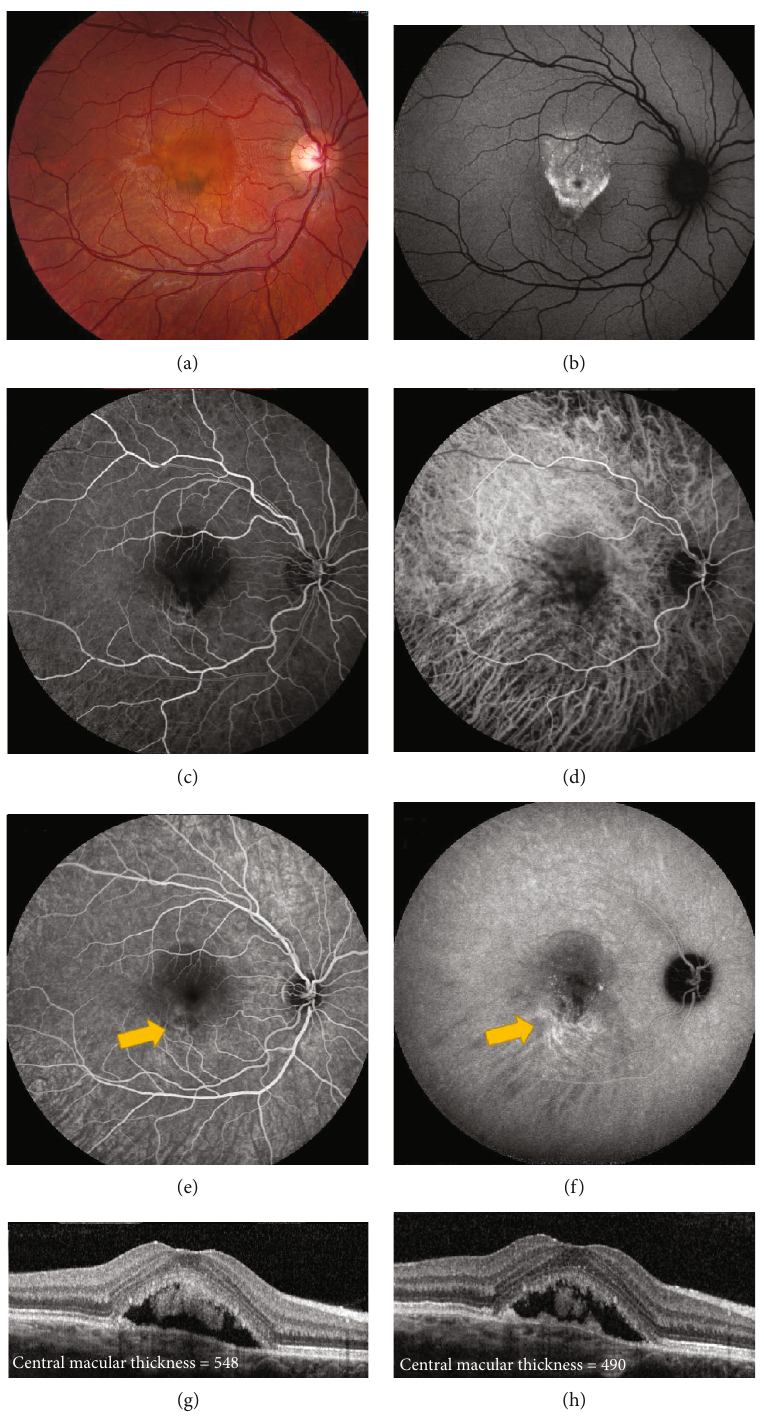
Figure 9: Chronic central serous chorioretinopathy treated with thermal photocoagulation. A 17-year old male presented with blurred vision of the right eye for nine months. Visual acuity was 20/50 in the right eye. (a) Fundus photography showed pigment changes and subretinal fl uid in the right eye. (b) Fundus auto fl uorescence showed hyperauto fl uorescence of the macula, corresponding to the subretinal fl uid seen clinically. (c, d) Early-phase fl uorescein angiography (FA) and indocyanine green angiography (ICGA) showed focal hyper fl uorescence corresponding to the inferior edge of the fl uid seen clinically. (e) Late-phase FA showed leakage in the inferior macula, noted by the yellow arrow. (f) Late-phase ICGA con fi rmed the leakage, noted by the yellow arrow. Thermal photocoagulation was chosen because of the young age and extrafoveal focal leakage. Yellow arrows indicate where thermal laser was applied. (g, h) Optical coherence tomography before (g) and one month after (h) thermal photocoagulation showed decrease in subretinal fl uid (measured in μ m) and improvement in central macular thickness. Visual acuity improved to 20/40+. The patient was then lost to